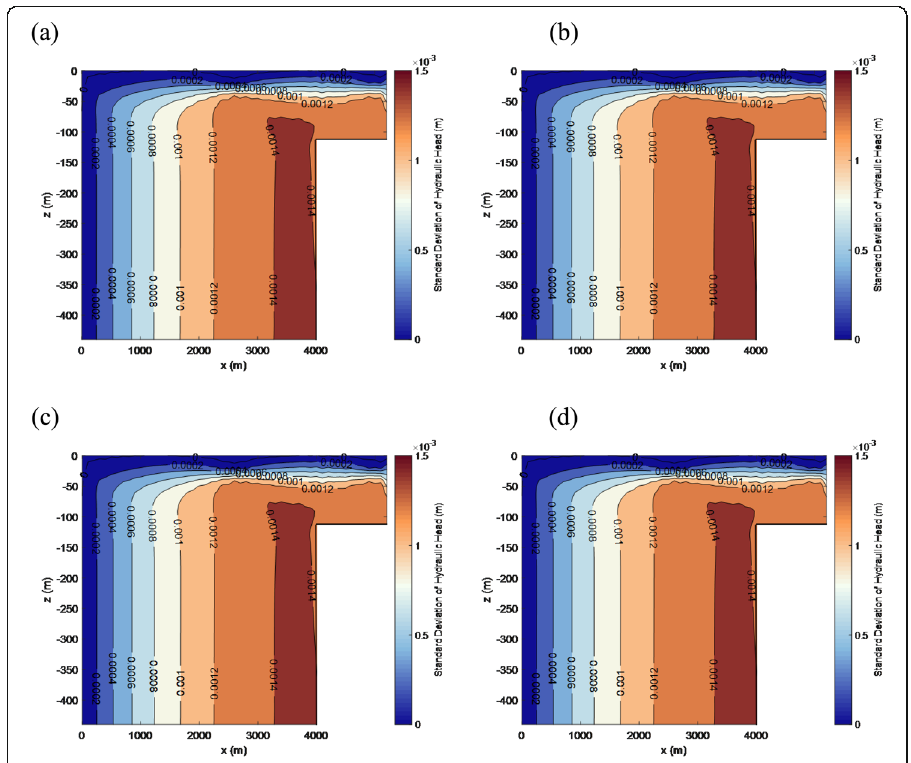
Fig. 11 Uncertainty of hydraulic head over the years considering the spatial variability of E a ( l x = 200 m, l z = 40 m, COV = 0.3). a Year 1. b Year 4. c Year 7. d Year